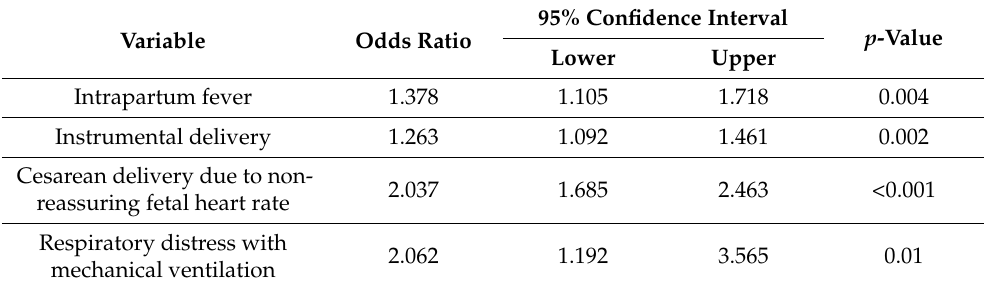
Table 4. Multivariate analysis model for adverse outcomes associated with thin meconium.